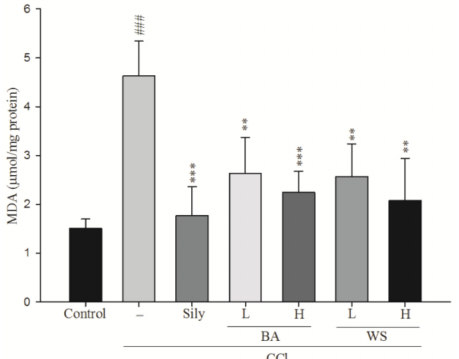
Figure 4. Effect of different fractions of black garlic and silymarin on hepatic MDA content in mice treated with CCl 4 . Each value represents as mean ± S.E.M. ( n = 10). ## p < 0.01, ### p < 0.001 as compared with the control group. ** p < 0.01, *** p < 0.001 as compared with the CCl 4 group (one-way ANOVA followed by Scheffe’s multiple range